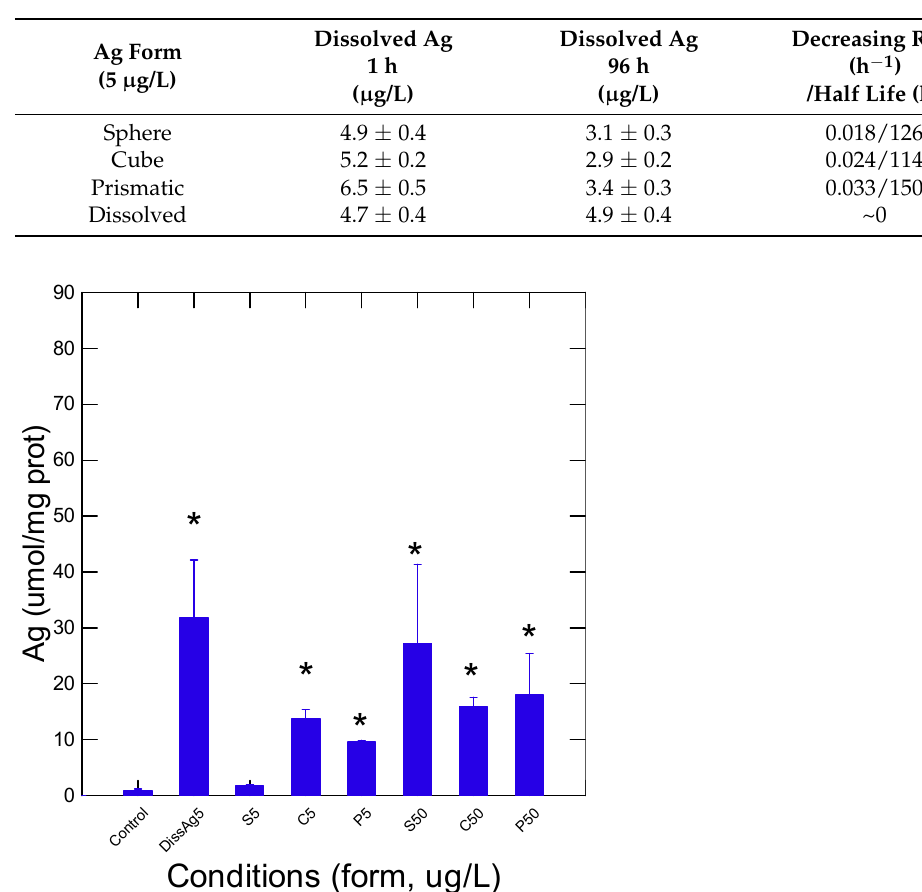
Table 1. Stability of Ag in the exposure media.